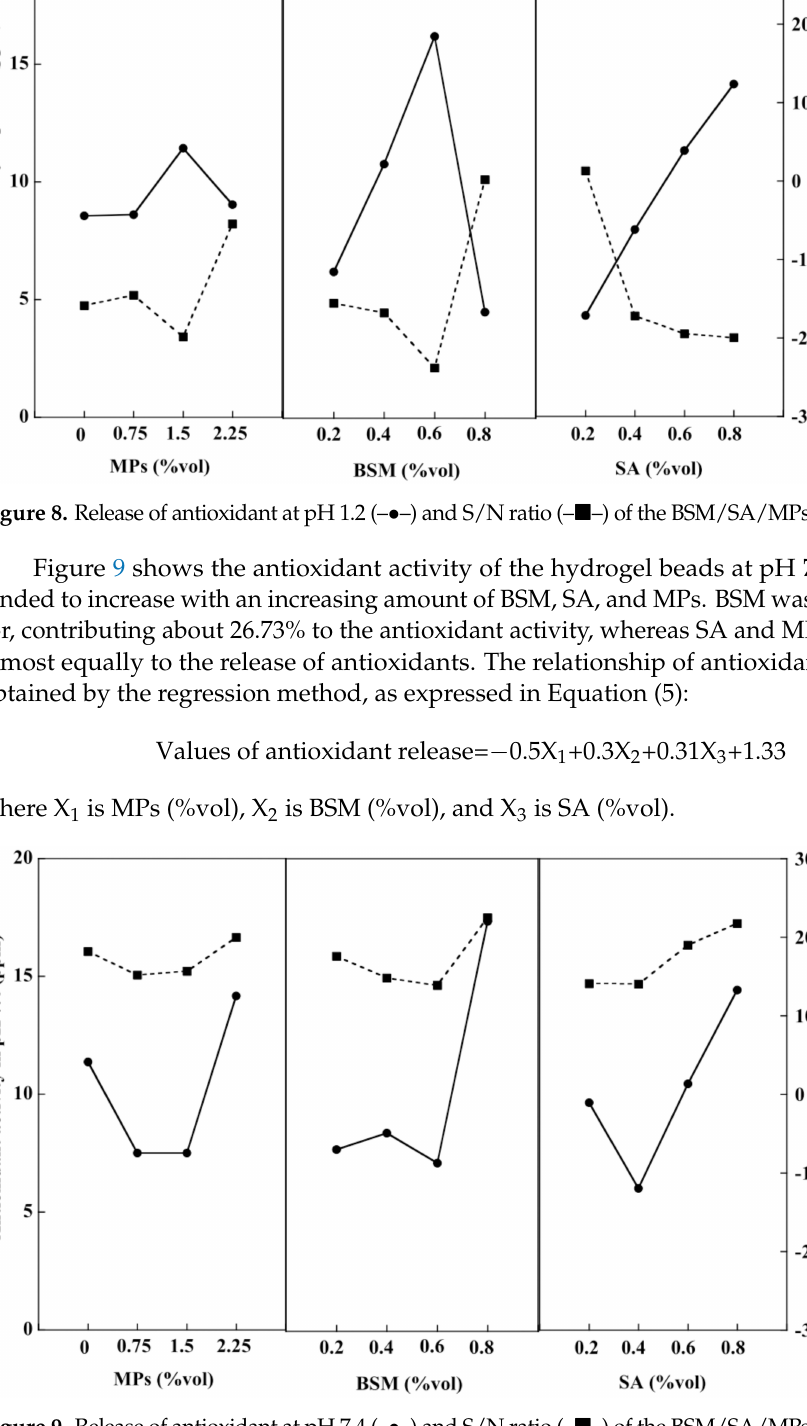
Figure 9. Release of antioxidant at pH 7.4 (– • –) and S/N ratio (– (cid:4) –) of the BSM/SA/MPs hydrogel